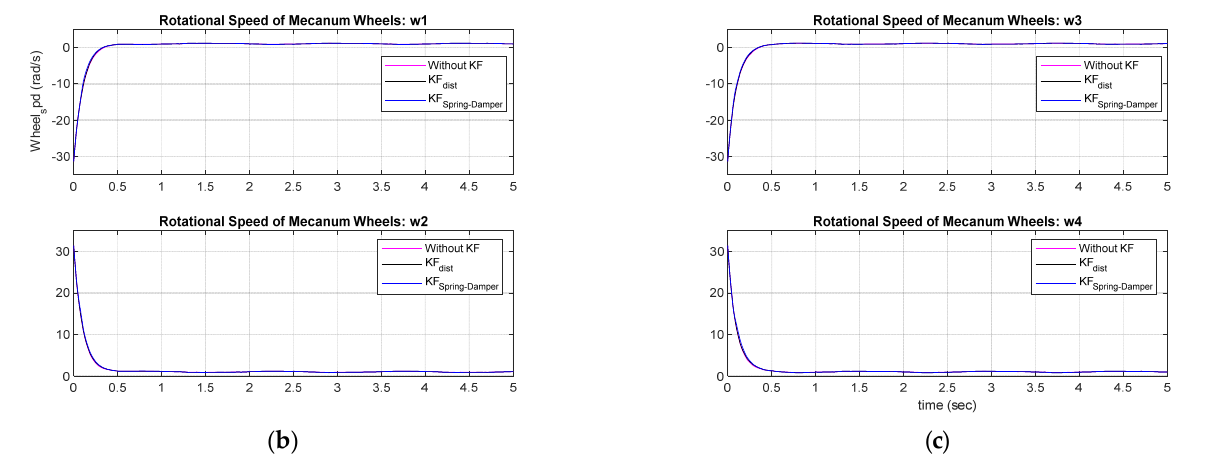
Figure 10. Control inputs for the MWR: ( a ) Linear and angular speed of the robot ( b , c ); Rotational speed of Mecanum wheel motor.